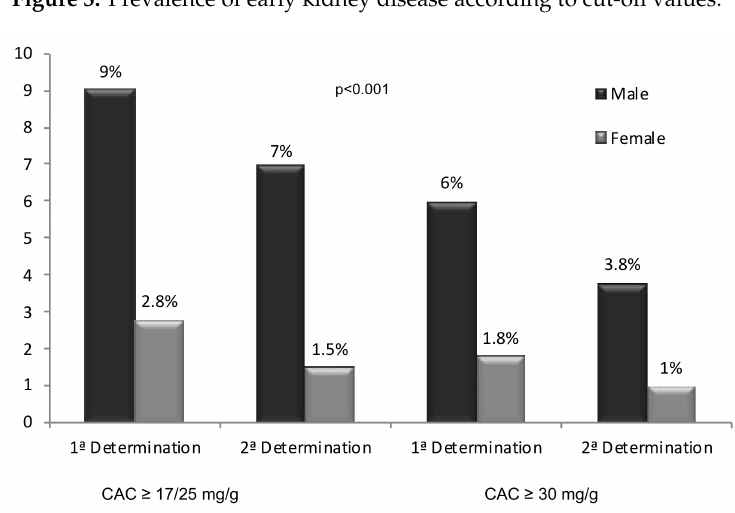
Figure 4. Prevalence of early kidney disease by gender.